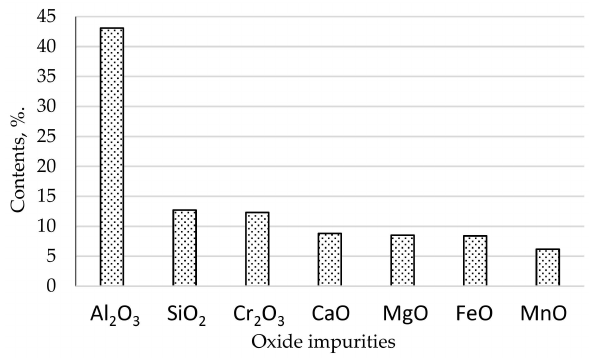
Figure 1. Types of oxide impurities content in the tested steel. The dimensional structure of impurities for an example heat of the tested steel is shown in Figure 2.